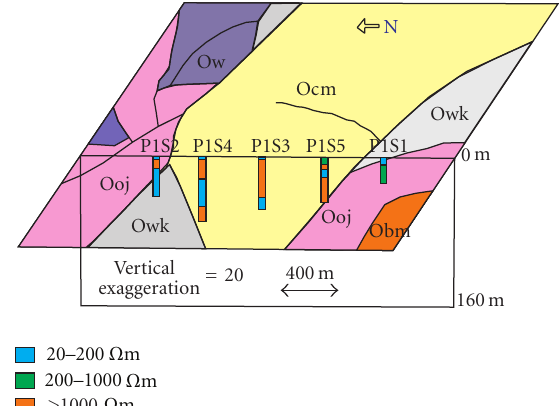
Figure 6: Diagram of subsurface resistivity model relative to surface geology. Cool Creek and McKenzie Hill Formations (Ocm), West Spring Creek and Kindblade Formations (Owk and Ow), Oil Creek Formation and Joins Formation (Ooj), and Bromide, Tulip Creek, and McLish Formations